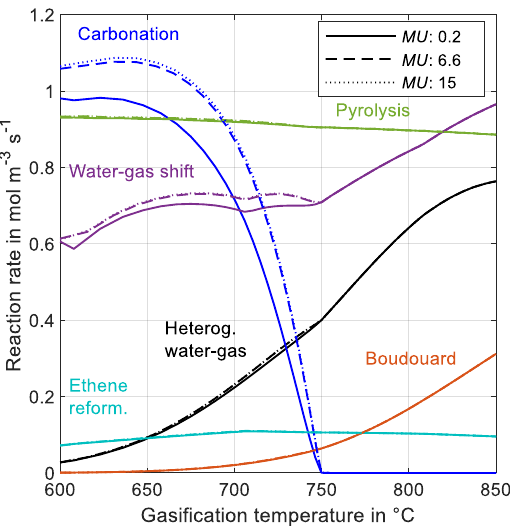
Figure 9. Reaction rates over temperature; influence of effective make-up of fresh limestone (lines for 0.2, 6.6, and 15 kg/h) to bed activity.